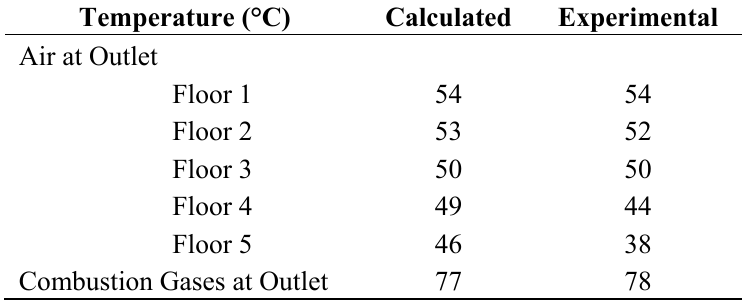
Table 8. Comparison of calculated and experimental temperatures of air and combustion gases at the outlet of concentric chimney and air supply